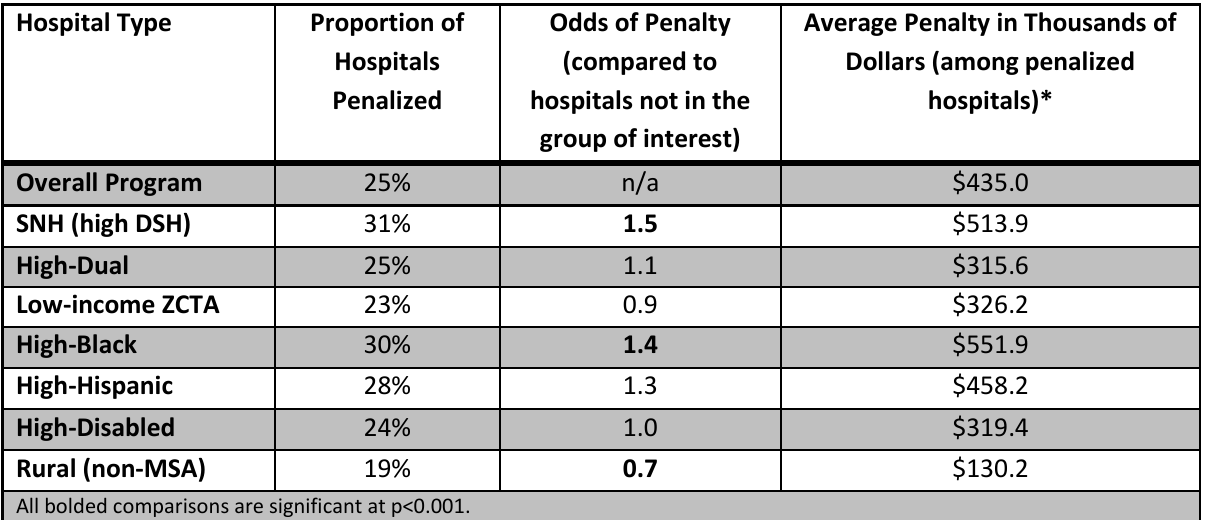
Table 6.10: Likelihood of Penalty and Average Penalty, by Hospital Type, FY2016 Hospital Type Proportion of